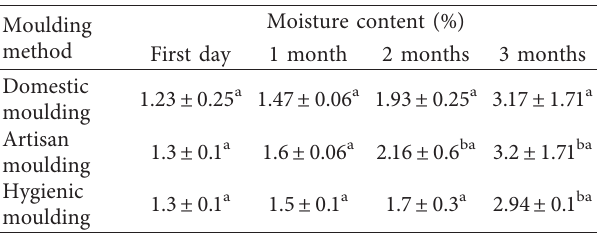
Table 1: Changes in the moisture content of peanut paste during storage according to the moulding